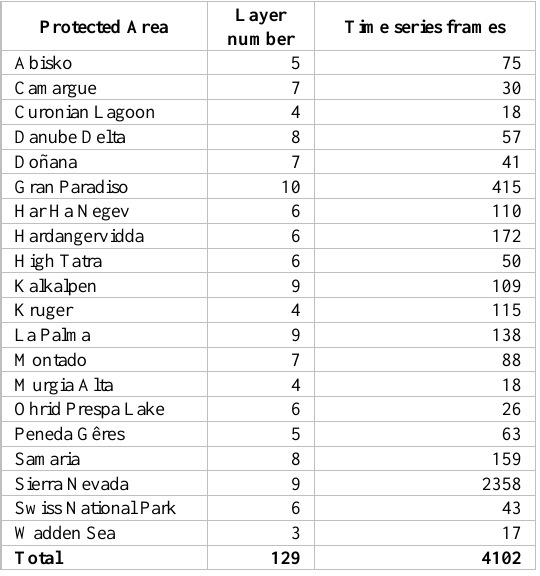
Table 1. Layers and frames in time series processed by Protected